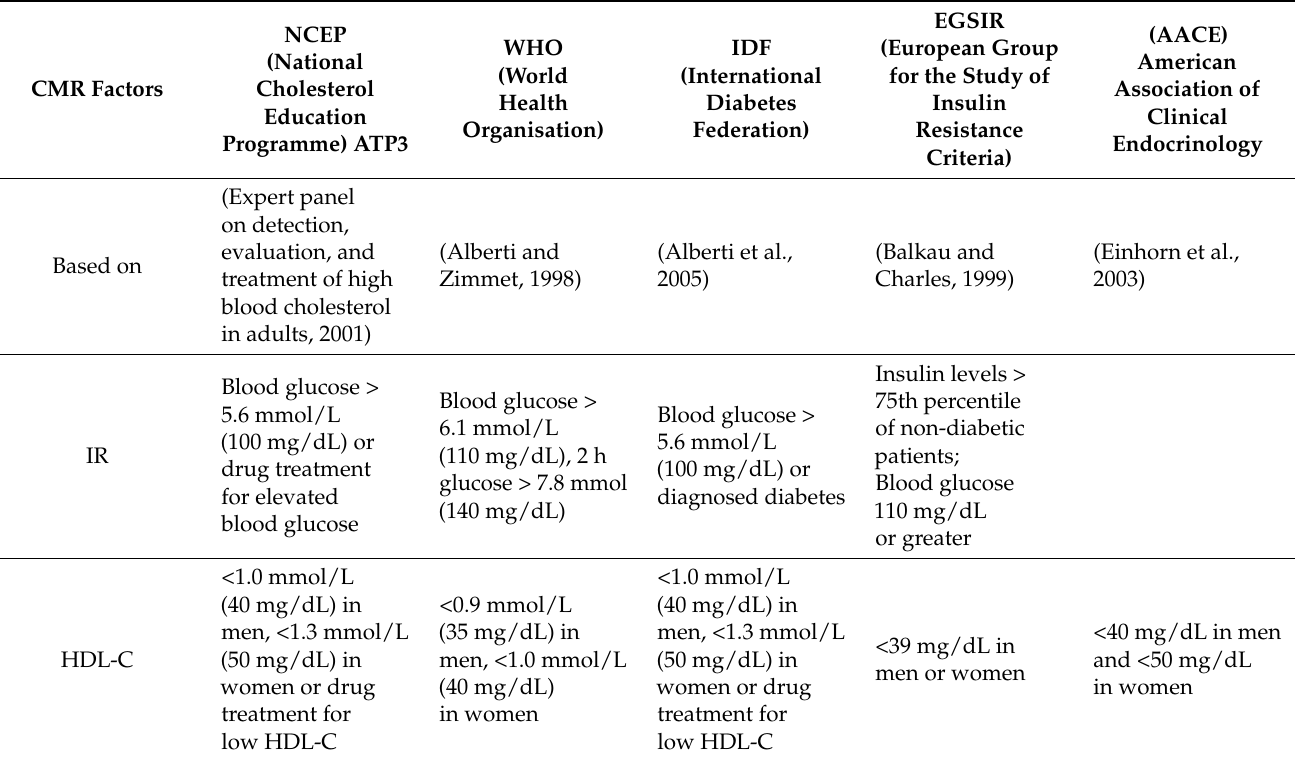
Table 1. Diagnostic biochemical and anthropometric criteria defining MetS according to